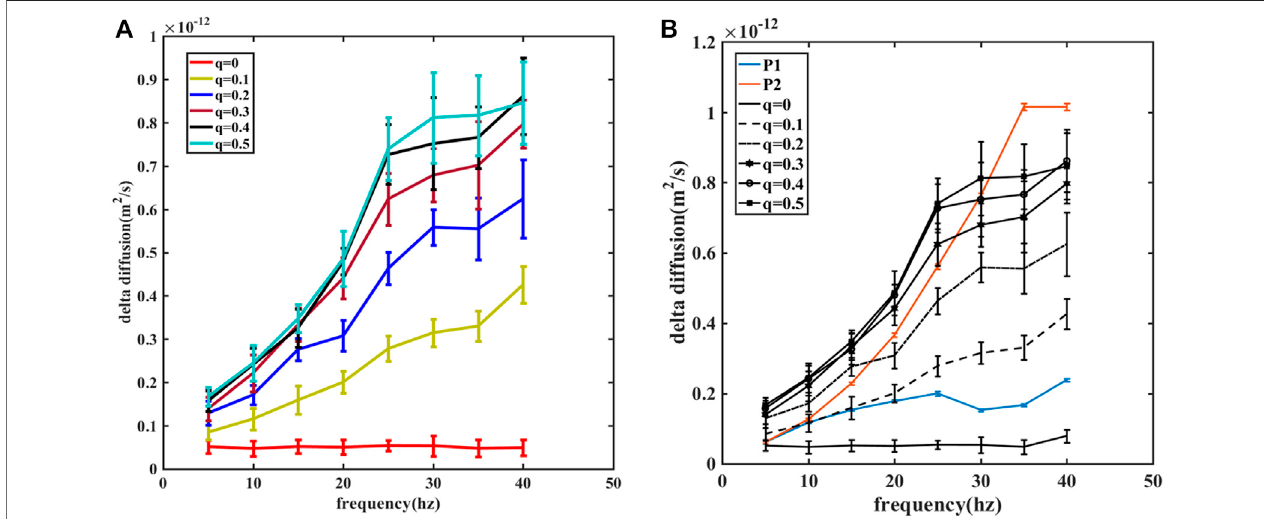
FIGURE 3 | (A) . Simulations are carried out to delineate the effect of ‘ q ’ on the enhancement of diffusivity. As the frequency of the fi eld is increased, the enhancement increases too. However, the introduction of q allows for much higher activity even at the same frequency. (B) . Enhancement of two sample swimmers is plotted onto the simulated results. It is evident that the P1 (red) and the P2 (blue) swimmers behave